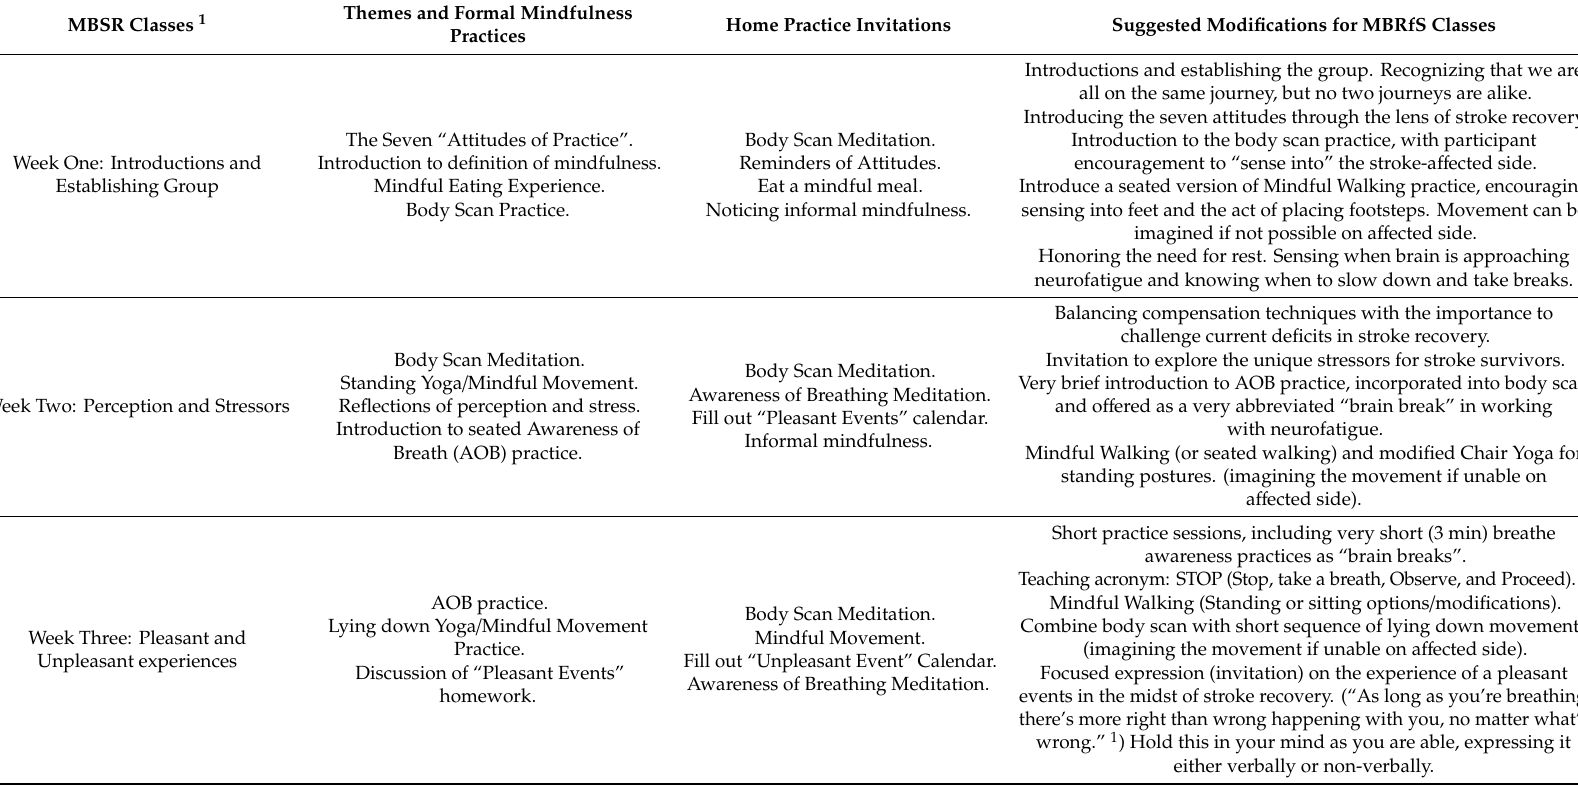
Table 1. Comparing traditional elements of the MBSR program with the proposed Mindfulness-Based Recovery from Stroke (MBRfS) program (class structure and